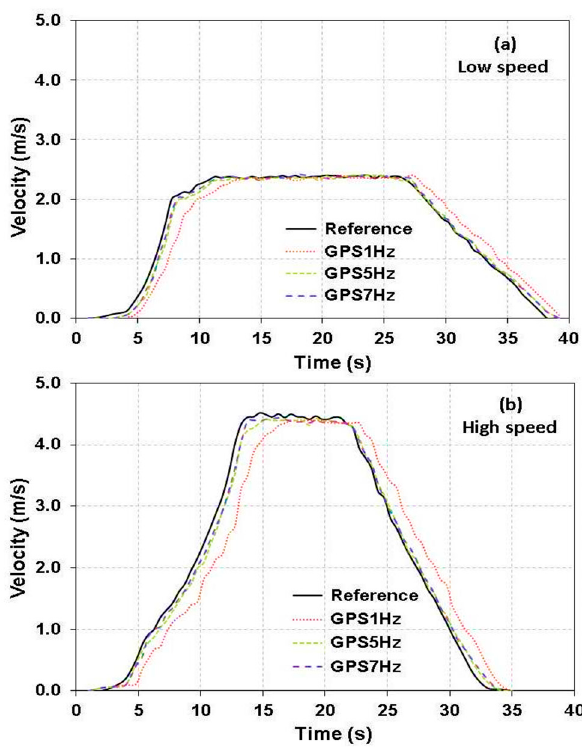
Figure 5. Comparison of the speed data from the three GPS speed sensors to the reference speed in low-speed levels ( a ) and high-speed levels ( b ).